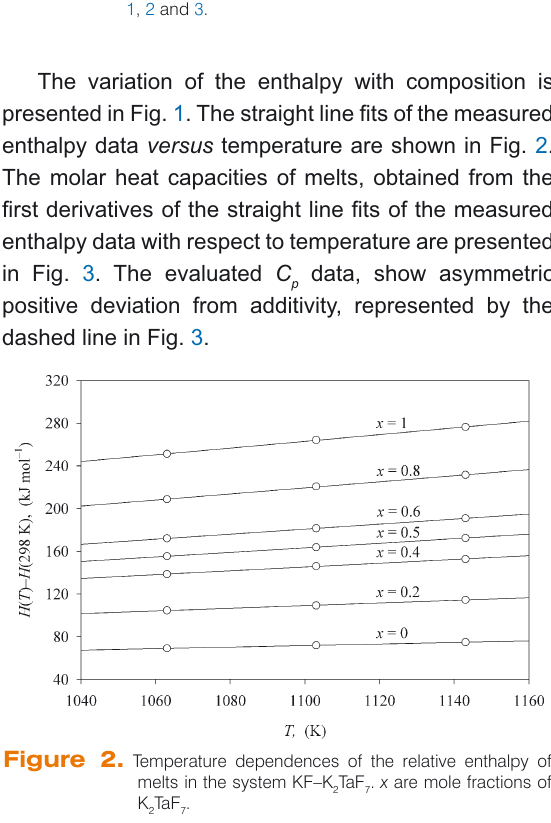
TaF . x are mole fractions of 2 7